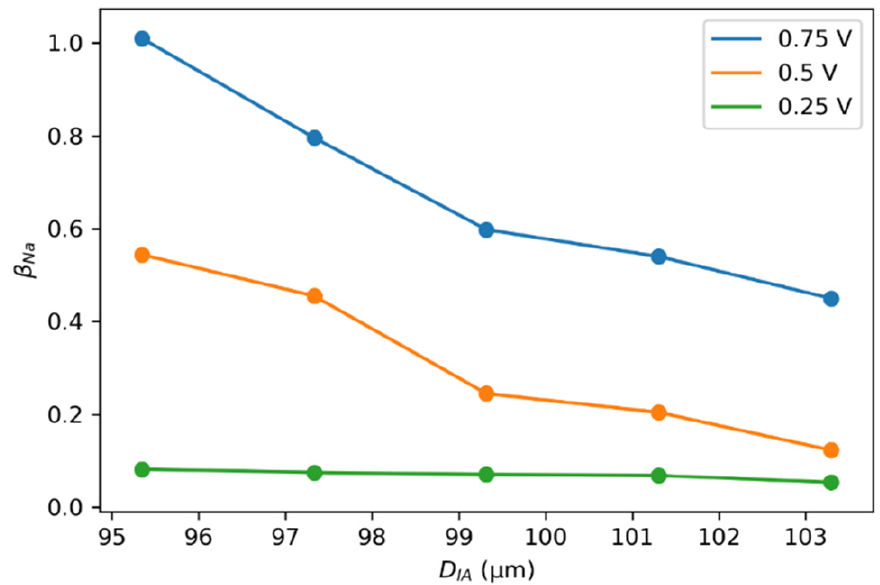
Figure 9. Effect of the interaction diameter on the average charge number, β Na with an SP size of 99.319 µ m. Individual calculations were performed using the experimental reference data of EFC